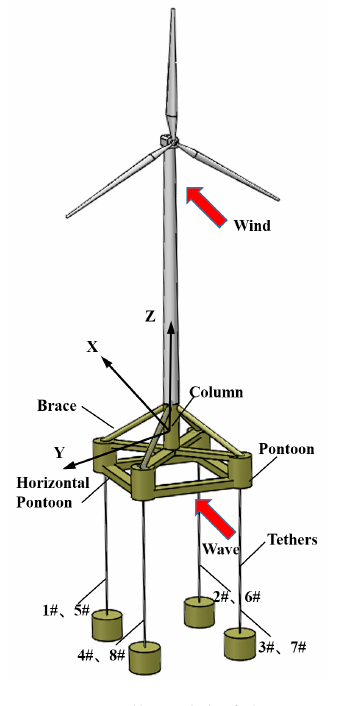
Figure 1. Overall model of the SFOWT.